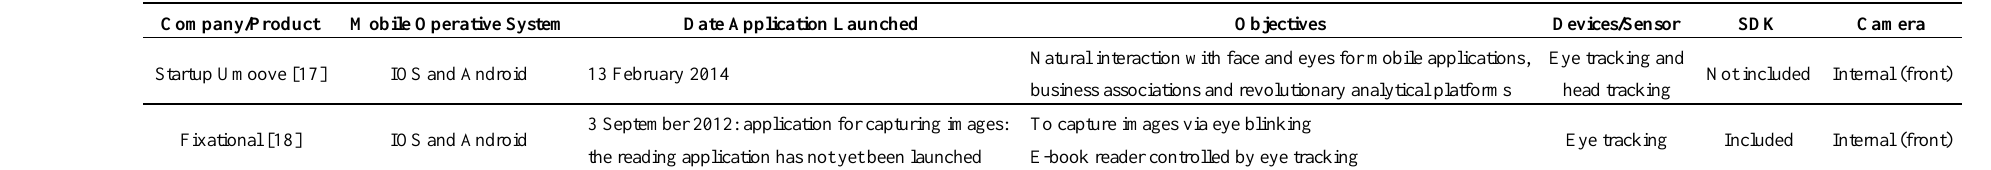
Table 3. Mobile Eye-tracking